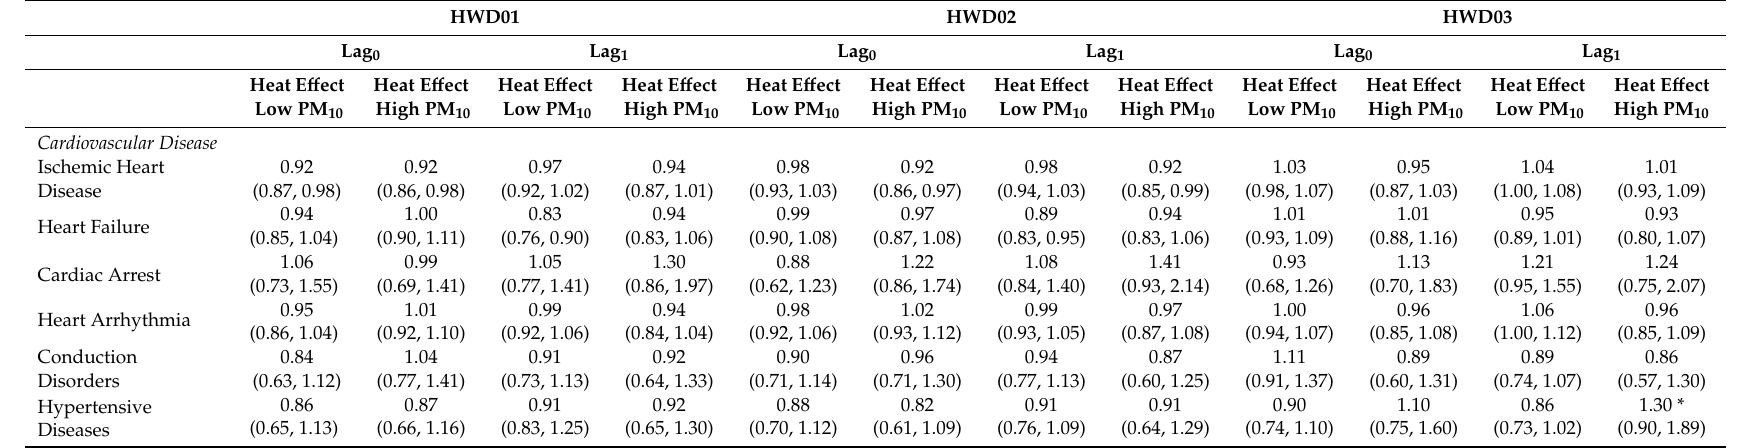
Table 4. The e ff ect of heat wave days on EHAs for six cardiovascular diseases on days with high levels of PM 10 compared to days with low levels of PM 10 in the SSD during the warm season, 2001 to 2013, for all ages. E ff ects are presented as odds ratios with their corresponding 95% confidence